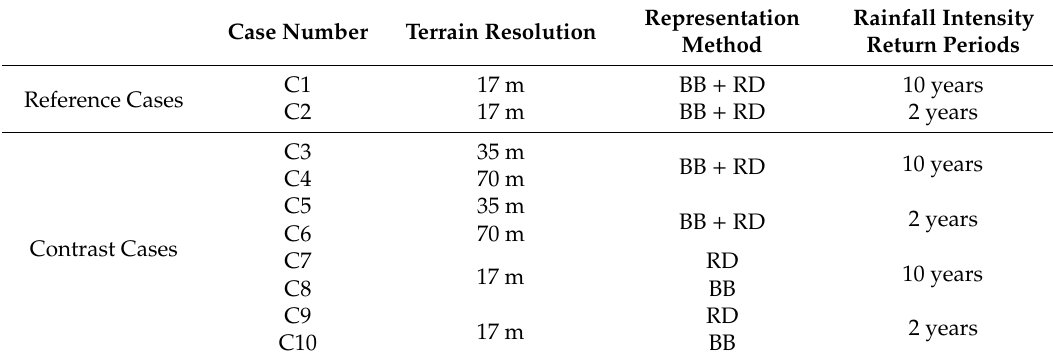
Table 1. Modeling scenarios using various resolutions, representation methods, and rainfall intensities.